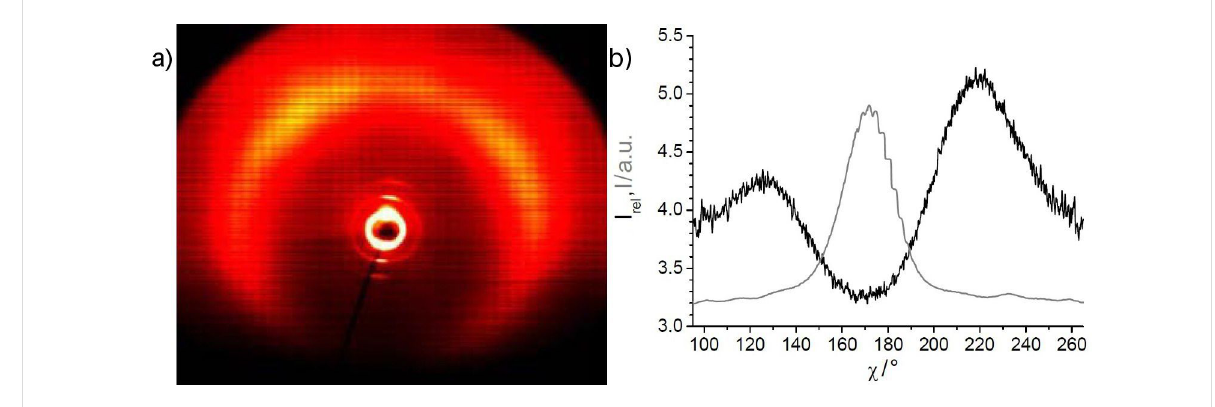
Figure 6: a) 2D X-ray pattern of a surface-aligned sample of compound OH 2a at 128 °C (lower part of the pattern shadowed by the heating stage); b) χ scan for the outer diffuse scattering with maxima at χ ≈ 125 and 220° [I rel = I(128 °C)/I(140 °C, isotropic liquid], and the position of the layer reflec- tions for comparison (gray line).